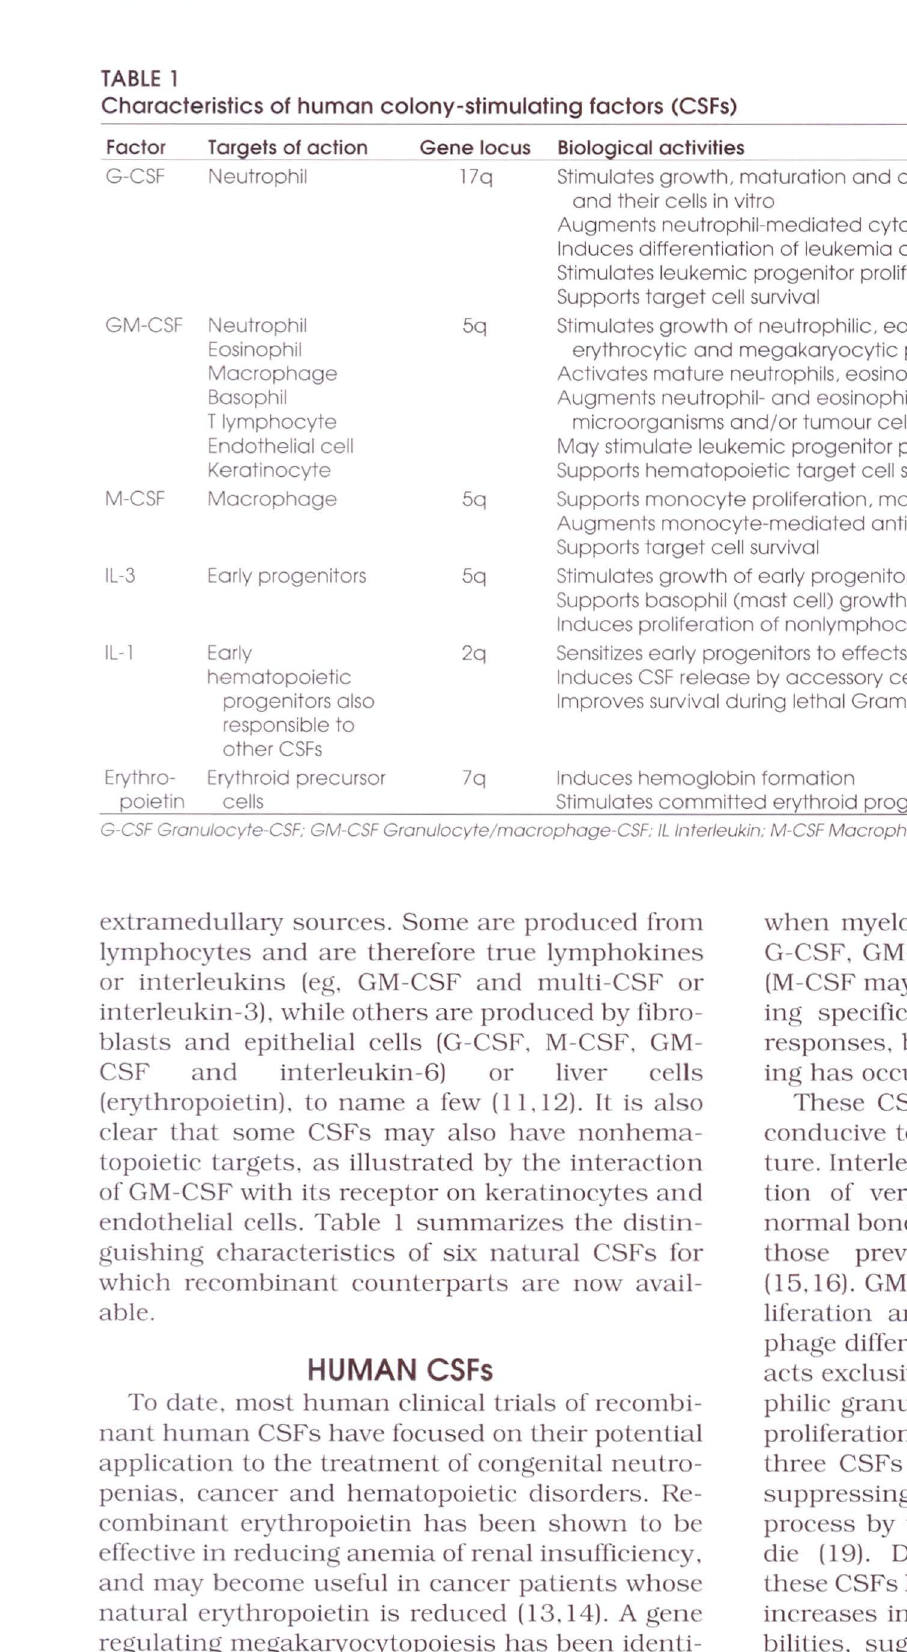
TABLE 1 Characteristics of human colony-stimulating factors